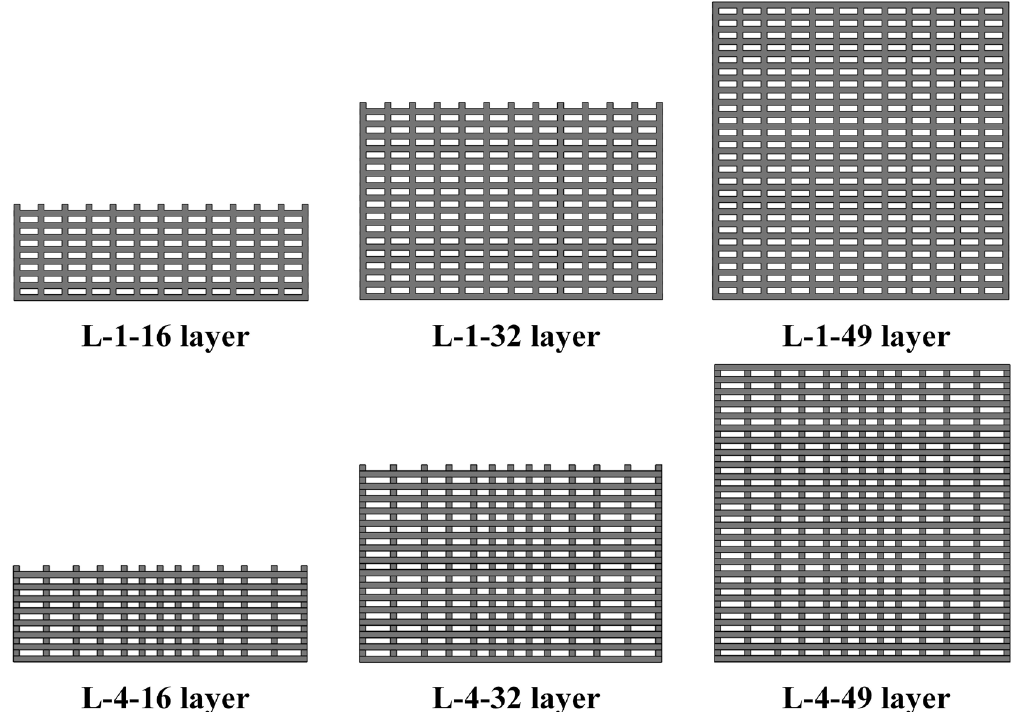
Figure 14. Plane diagrams of specimens with different lattice heights.